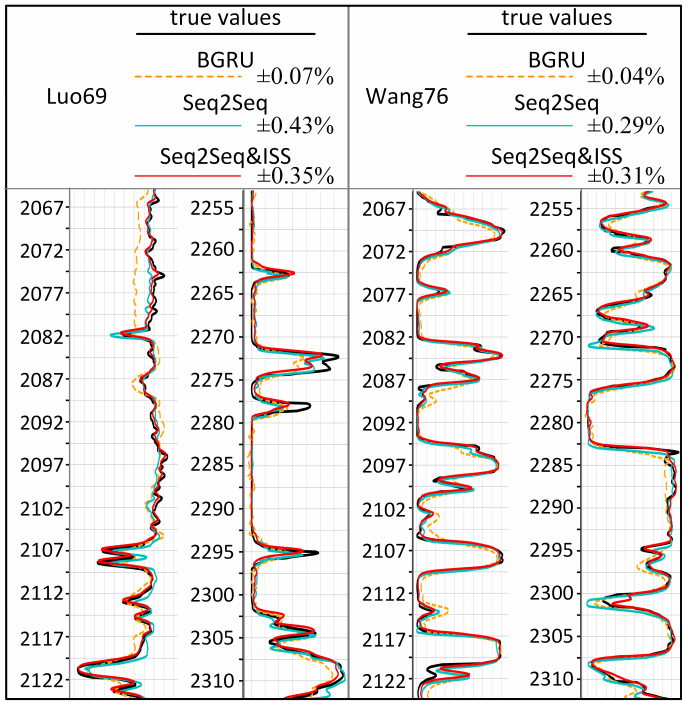
Figure 12. Prediction of Seq2Seq and BGRU for wells Luo69 and